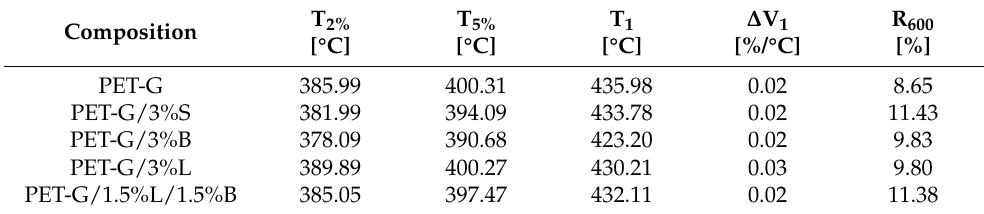
Table 6. The results of research on the properties of thermostability of composites.